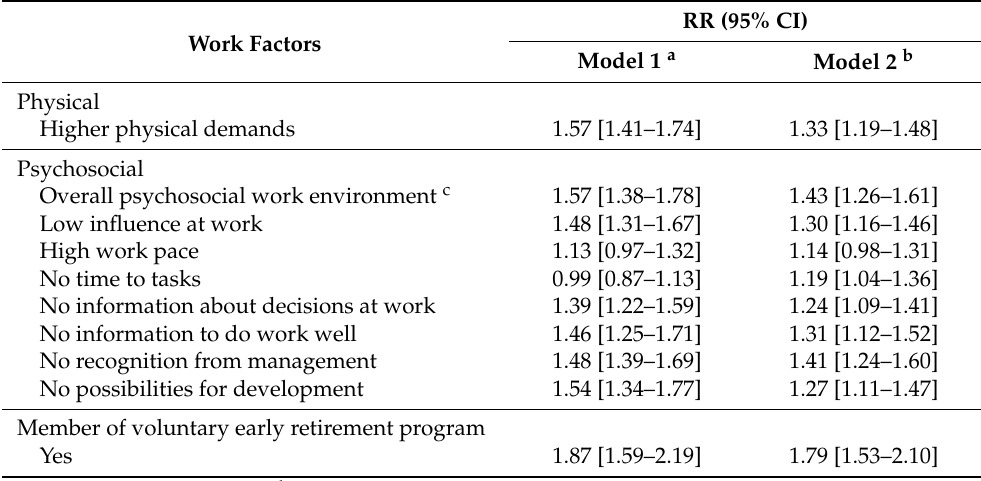
Table 2. Association between physical and psychosocial work factors and early retirement. The risk ratios (RR) represent the highest value of each scale (reference: the lowest value). CI = confidence interval.